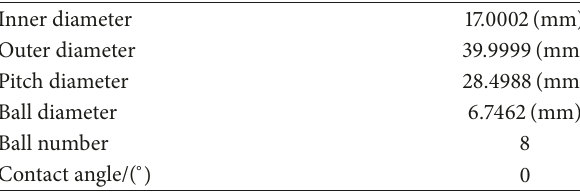
Table 1: The main parameters of the rolling bearings.